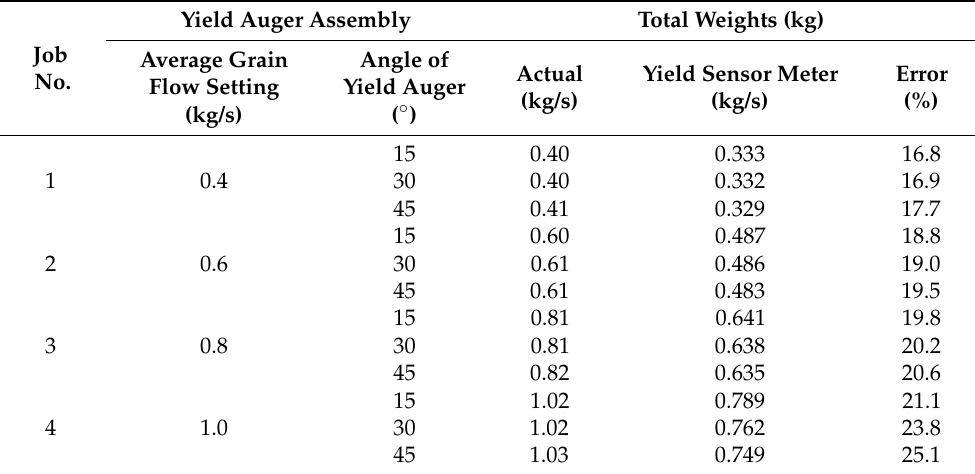
Table 2. Effect of yield weight (kg s − 1 ) and angle of yield auger (degree) variability on average grain flow (kg s − 1 ).